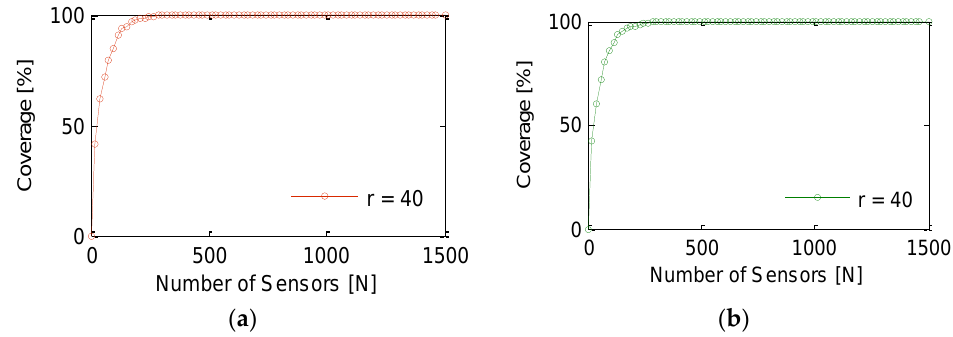
Figure 12. Comparison of coverage provided by proposed framework and literature ( a ) GC-IoT; ( b ) GS-IoT.